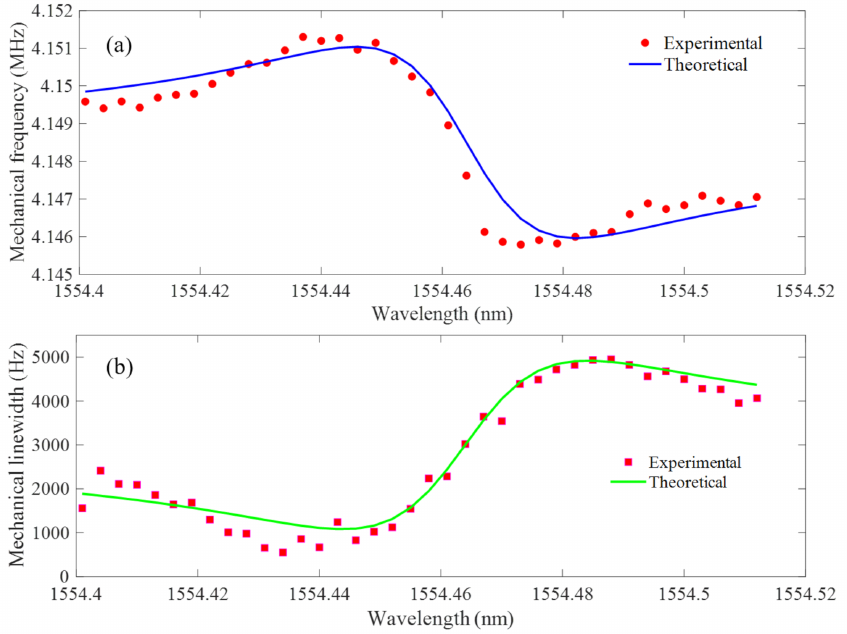
Figure 8. Mechanical frequency Ω m ( a ) and linewidth Γ m ( b ) of the mechanical motion mode IP1 as a function of laser detuning around the wavelength of 1554.464 nm. Both theoretical fitting curves are calculated using Ω m , Γ m , ω cav and κ from the experiment (m eff = 3 pg, ω κ = 4.22 GHz, Ω m /2 π = 4.148 MHz, Γ m /2 π = 1.62 kHz, g